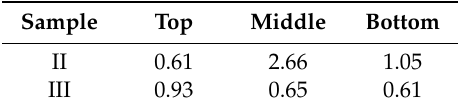
Figure 2. The distribution of Al element in the weld joints of three samples ( a – d ): ( a ) along weld-width direction of sample I; ( b ) along weld-width direction of sample II; ( c ) along weld-width direction of sample III; ( d ) along the center line of there samples. Table 4. Di ff erence in the Al content in the range of 0.5 mm from the center line of sample II and III welds